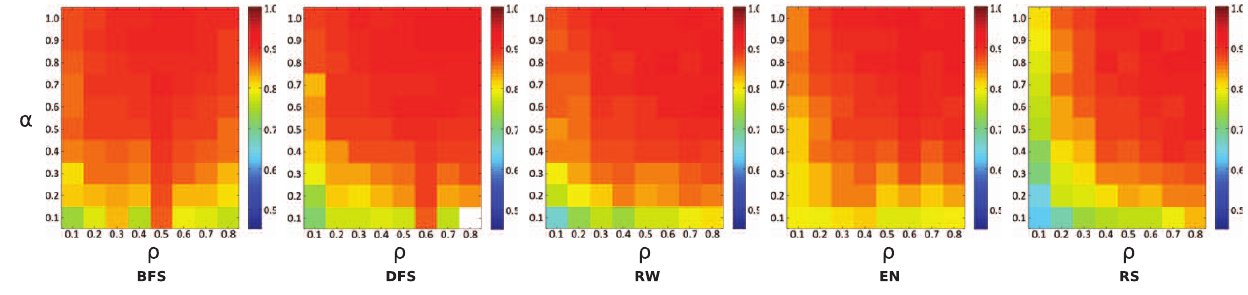
Figure 5. Prediction accuracy ( AUC ) of samples based on all member recruitment models in the cross-validation training scheme applied to UNC data. The white square denotes a data point where there was not enough data to make the prediction.